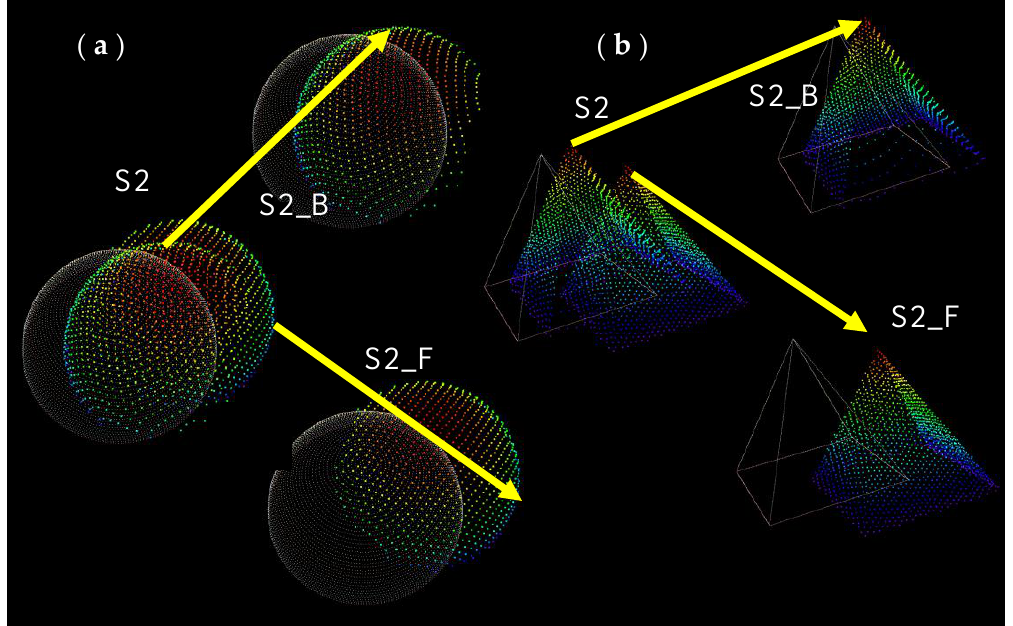
Figure 6. Intraswath boresighting error shown in opposite scan direction. Swath 2 data shows two apparently misaligned targets due to boresighting error. The arrows indicate the separated forward and backward scanned point cloud. ( a ) Swath 2 separated into forward and backward scan directions. ( b ) Same situation as hemisphere, but with a pyramid object.